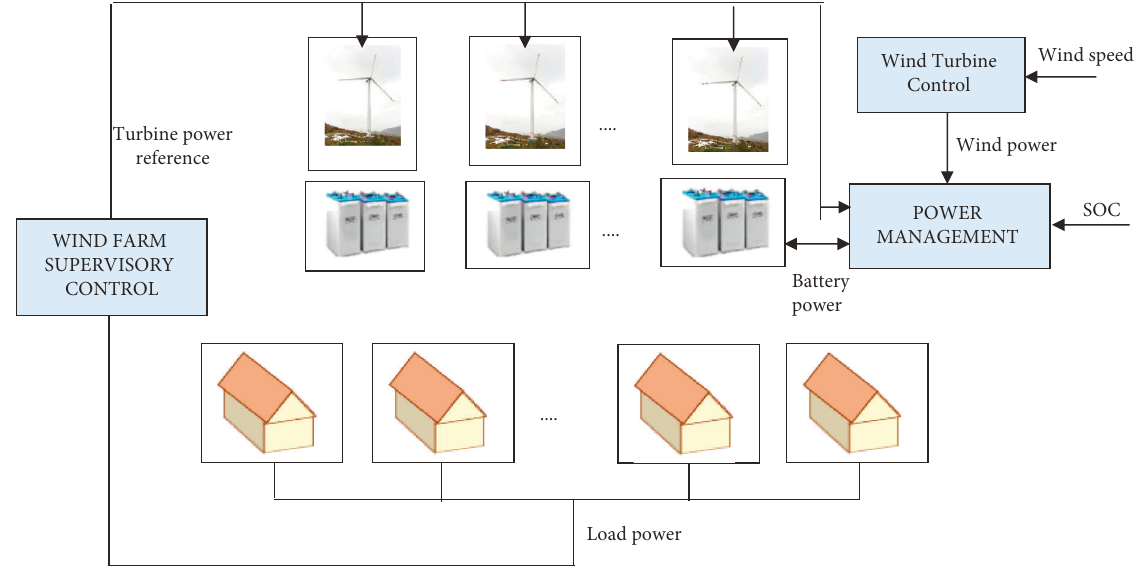
Figure 4: Proposed power management and control system.